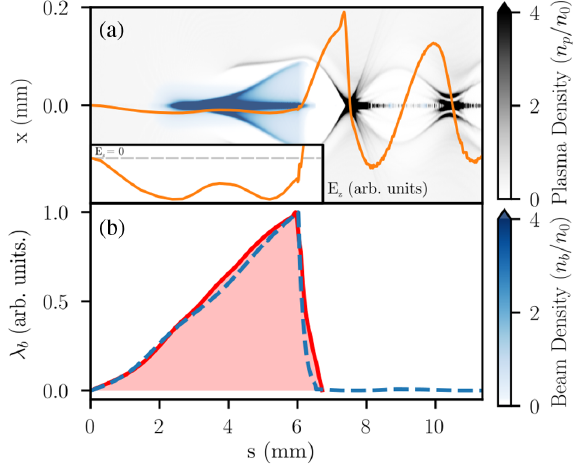
cmFIG. 2. WARP simulation of a ramped beam after propagating 34 mm through a uniform plasma. (a) Longitudinal cross-section of the beam (blue) and plasma (grey) electron densities with the on-axis longitudinal electric field. Inset: magnified view of the on-axis longitudinal wakefield. (b) Comparison between PIC simulated longitudinal current distribution (blue, dashed) and the single mode bunch reconstruction (red, filled) from the simulated wakefield E z